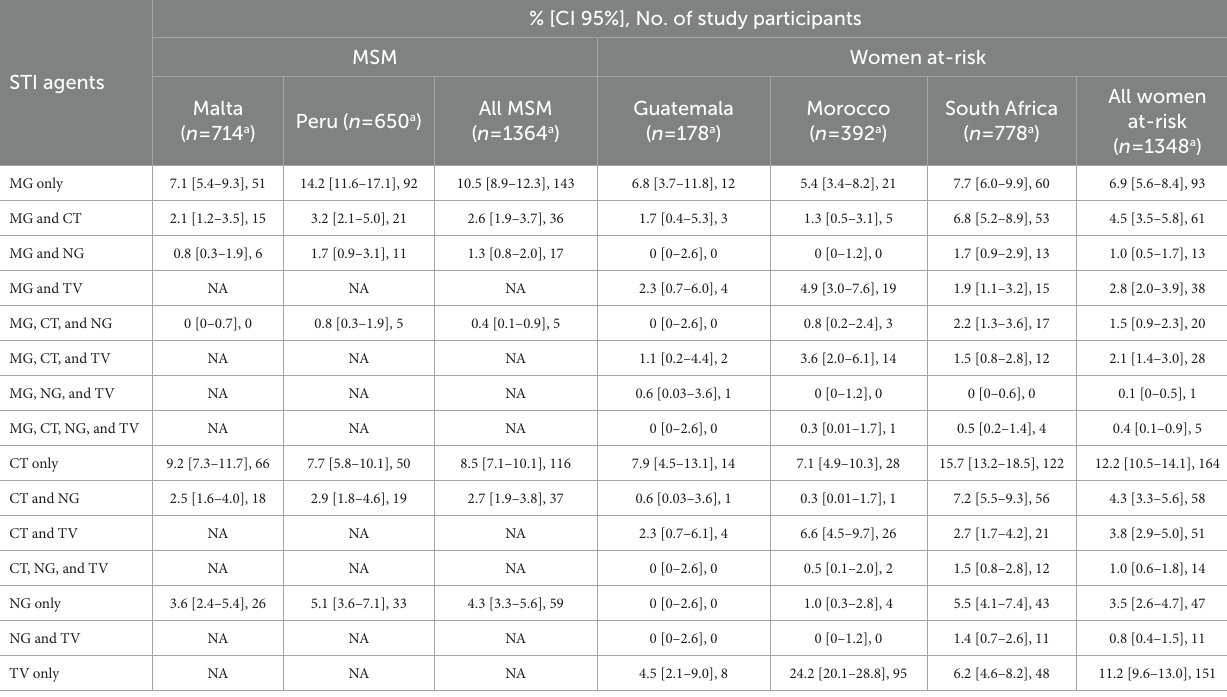
TABLE 3 Infections with M. genitalium , Chlamydia trachomatis, Neisseria gonorrhoeae, and Trichomonas vaginalis , including coinfections, in high-risk populations in five countries in four WHO Regions. % [CI 95%], No. of study participants MSM Women STI agents